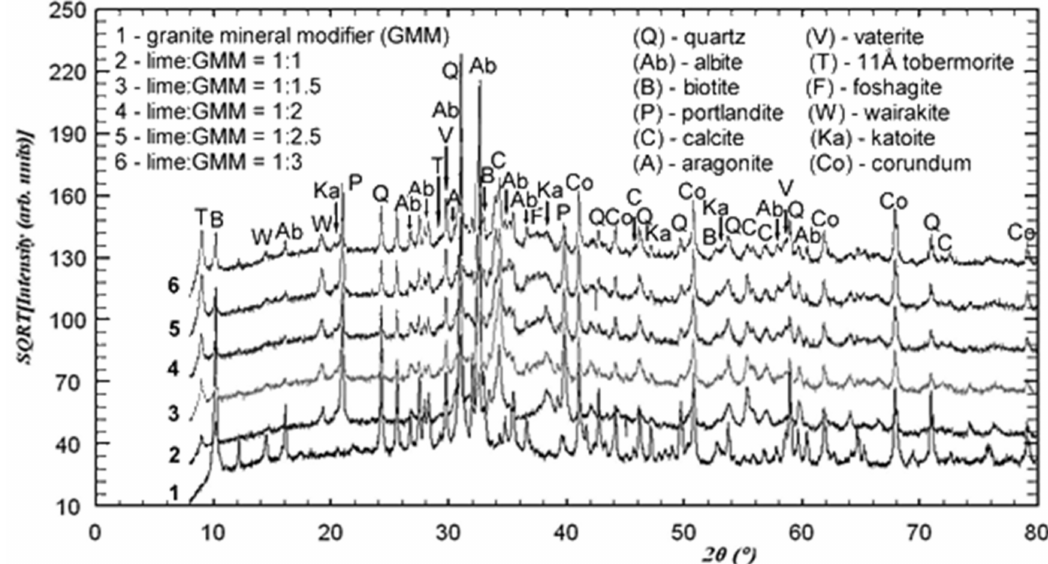
Figure 3. XRD patterns for GMM and autoclaved experimental samples. Visualization of weak reflections is realized by √ Y-axis scaling calibration in